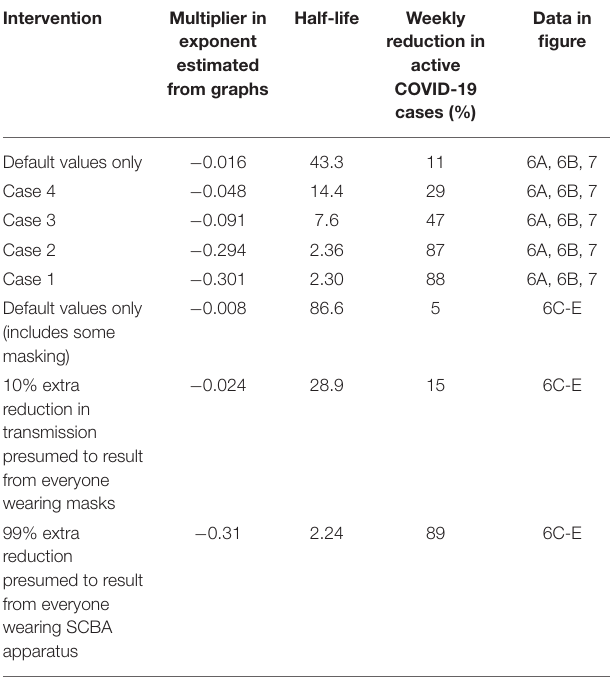
TABLE 4 | Estimates of T 1 / 2 of “infectious” individuals with different late mask interventions. Intervention Multiplier in